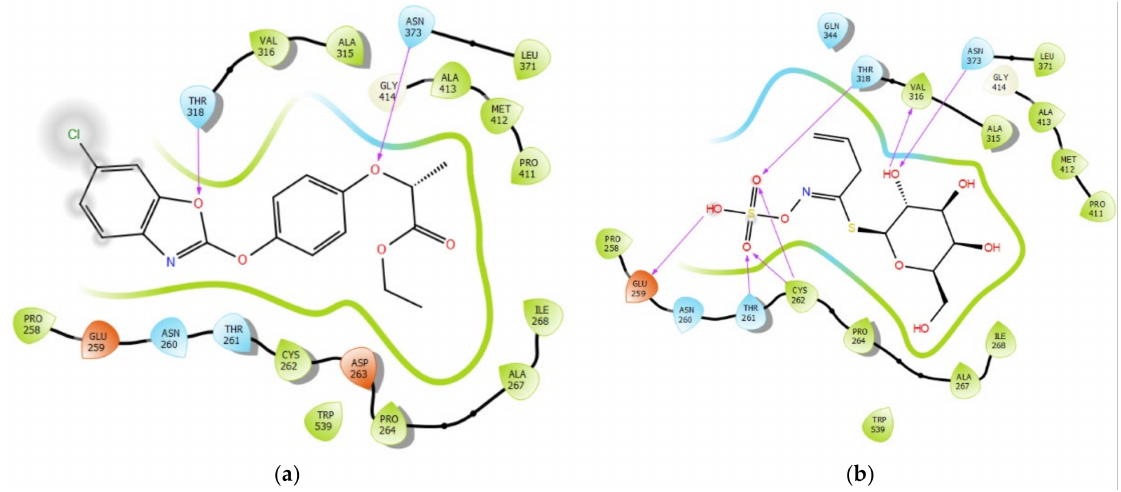
Figure 3. Interaction pattern of ( a ) fenoxaprop-p-ethyl and ( b ) sinigrin within the active site of ACCase.